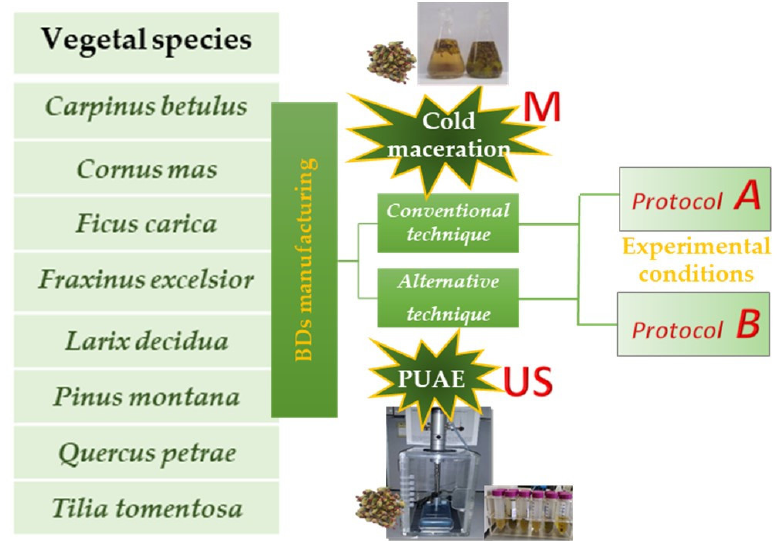
Figure 1. The global scheme of the experimental manufacturing of BDs: two methods (cold maceration, namely M, and ultrasounds, namely US) have been used. Each method has been applied following two different protocols (A and B).